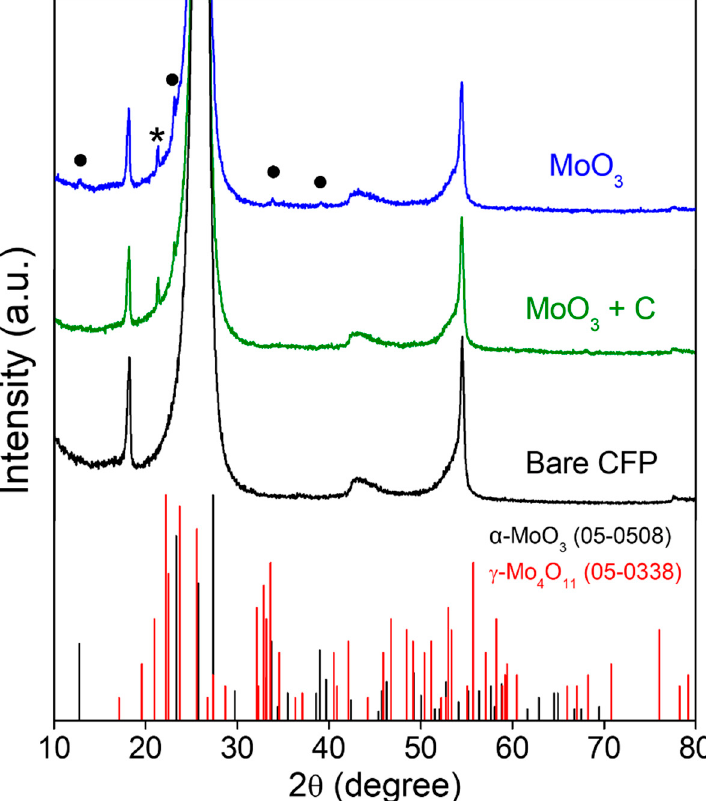
Figure 4. XRD patterns of the molybdenum oxide nanoparticle aggregates prepared on CFP substrates by the CVT method using two different types of precursors: MoO 3 and 1:1 (mol/mol) mixture of MoO 3 and activated carbon and that of bare CFP (“ • ” and “*”represent the peaks arising from α -MoO 3 and γ -Mo 4 O 11 phases, respectively). The bottom bars are JCPDS standards for orthorhombic α -MoO 3 (no. 05-0508) and γ -Mo 4 O 11 (no. 05-0338).